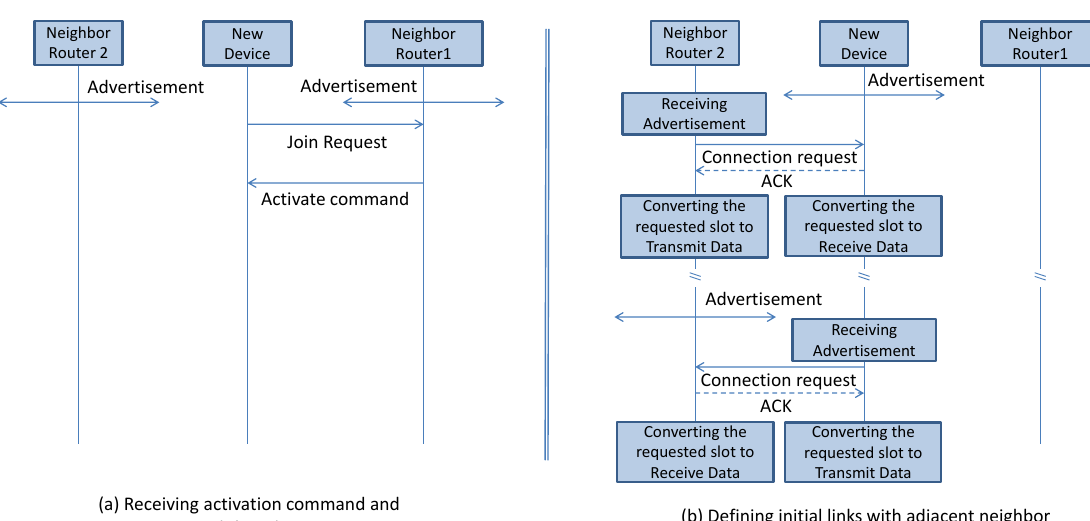
Figure 12. Receiving activation command ( a ) and defining initial communication links with neighbors ( b